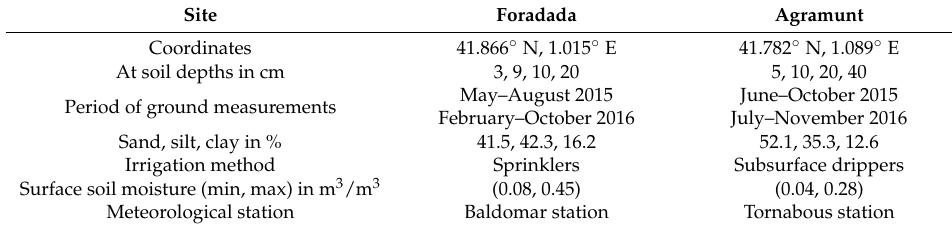
Table 1. Ground soil moisture measurements in two demonstration fields at Foradada and